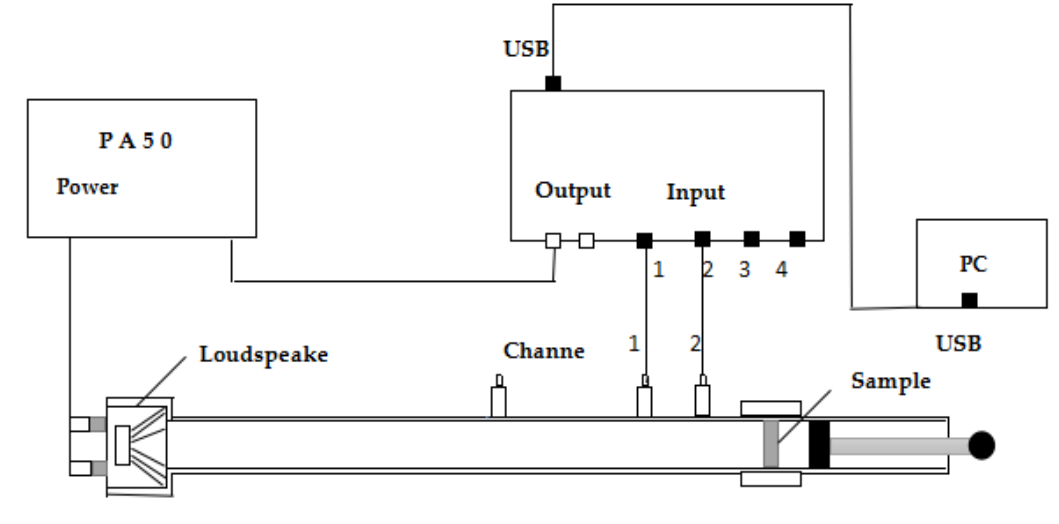
Figure 2. The structure of impedance tube.